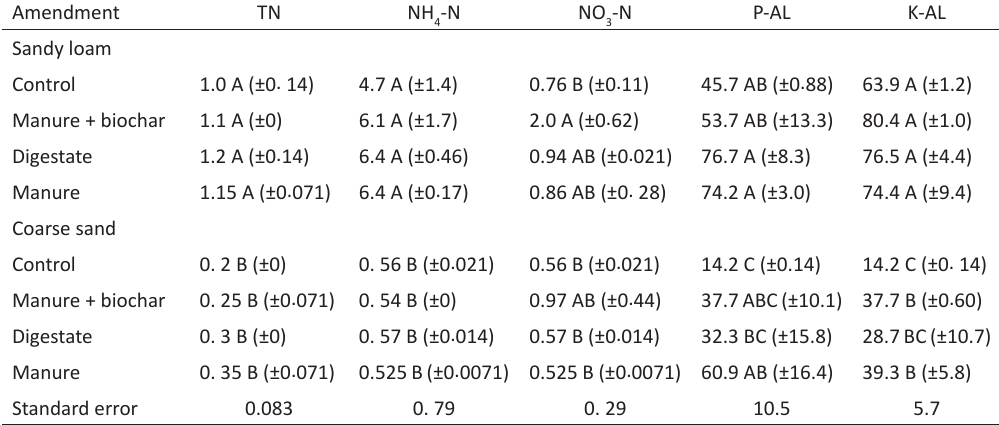
Table 5. Amount of Kjeldahl nitrogen (TN) (g kg -1 DM), ammonium-N (NH DM) and plant-available phosphorus (P-AL) and potassium (K-AL) (mg kg -1 DM) in the Særheim plots that received different amendments in March 2018 (±1 standard deviation for each amendment and soil combination is given within parenthesis). Different letters within columns indicate statistically significant differences ( p <0.05).